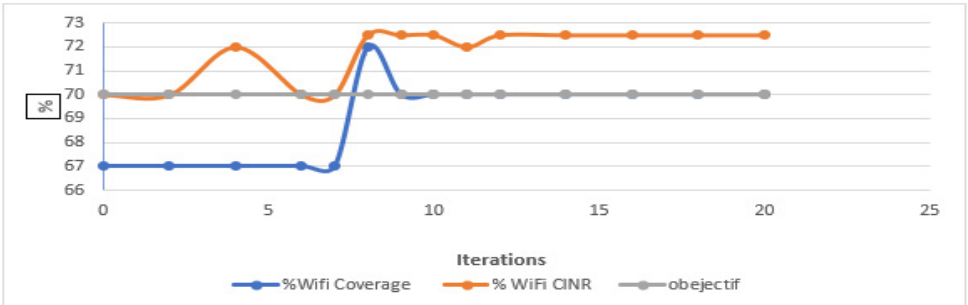
Figure 7. Coverage evolution and signal quality as a function of iterations.